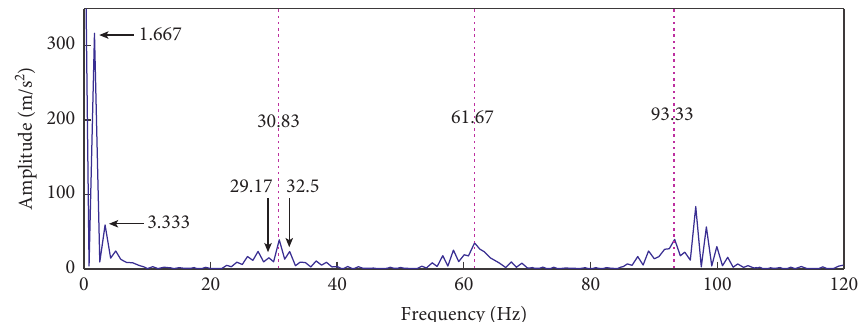
Figure 24: Envelope spectrum of meshing force for s- p